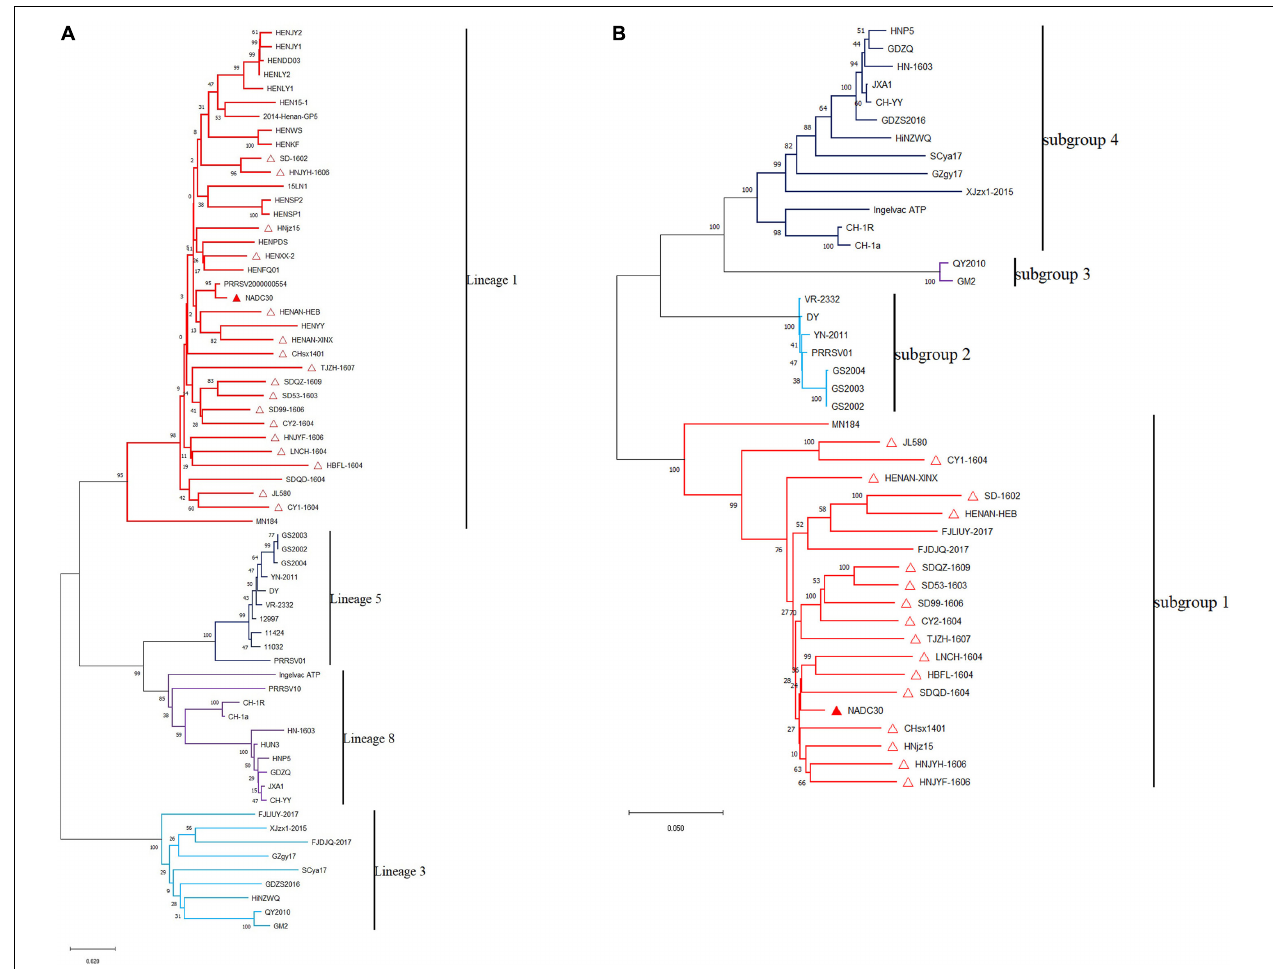
FIGURE 1 | Phylogenetic tree based on PRRSV ORF5 (A) and nsp2 gene (B) sequences. The phylogenetic tree was constructed using the neighbor-joining method in MEGAX64 with 1,000 bootstrap replicates. Multiple sequence alignments were generated using MUSCLE. NADC30 (GenBank number: JN654459) and 17 references NADC30-like PRRSV strains are indicated by closed red triangles and open red triangles,